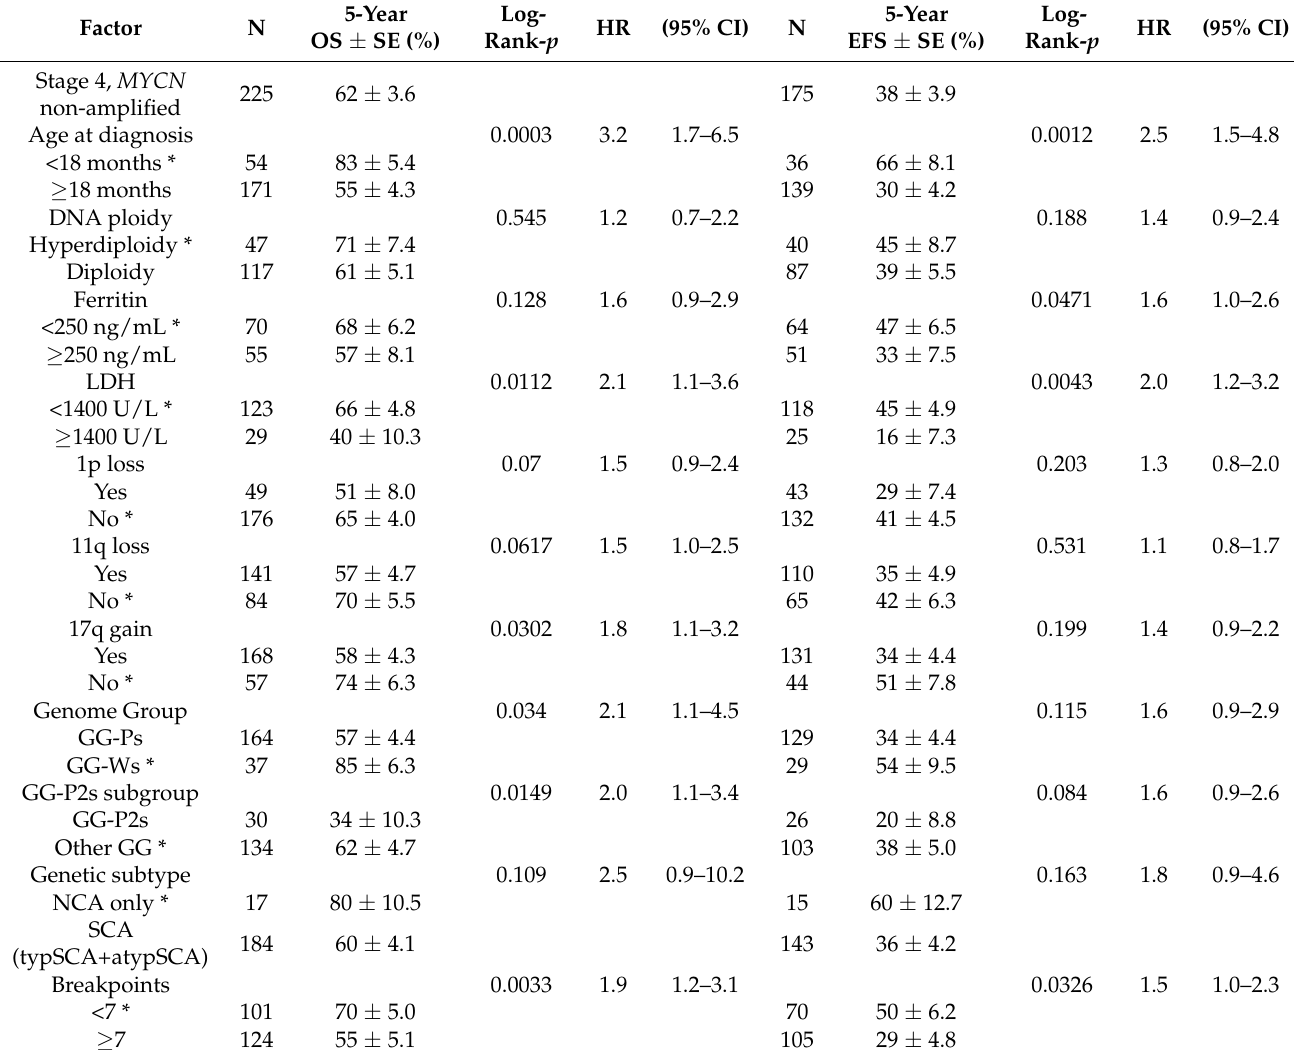
Table 3. Prognostic significance of individual factors in stage 4, MYCN non-amplified